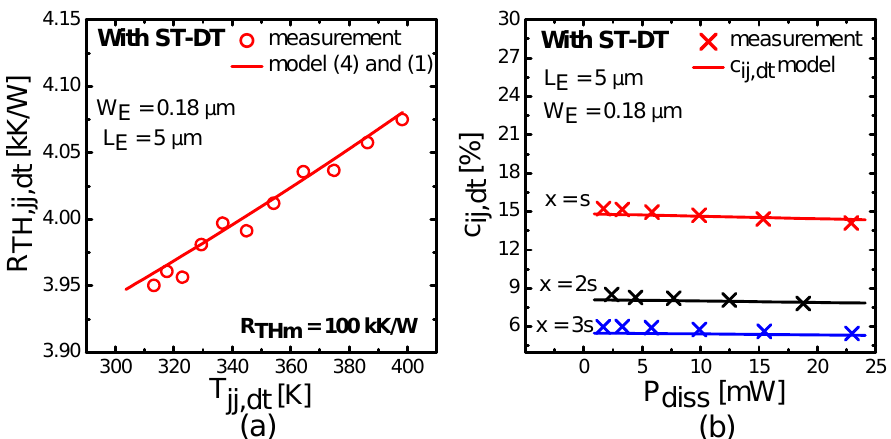
Figure 9. ( a ) T jj , dt —dependent R TH , jj , dt and ( b ) c ij , dt at different sensing fingers: A comparison between the proposed model (lines) and measurements (symbols) [23] for a device with A E = 0.18 × 5 µ m 2 . ∆ T ∆ T = 2.03 was used in the model. Here finger spacing s = 5 µ m. ij , st ij , dt /